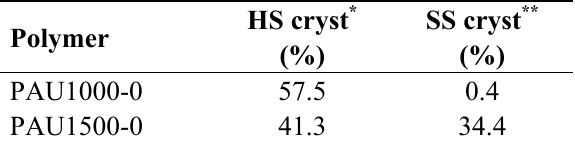
Table 1. Hard and soft segment crystallinity of non-incubated PAUs determined by